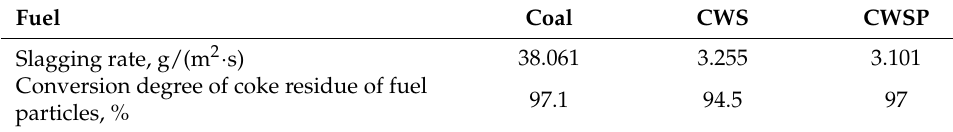
Table 9. Average slagging rates of furnace walls when burning different fuels.